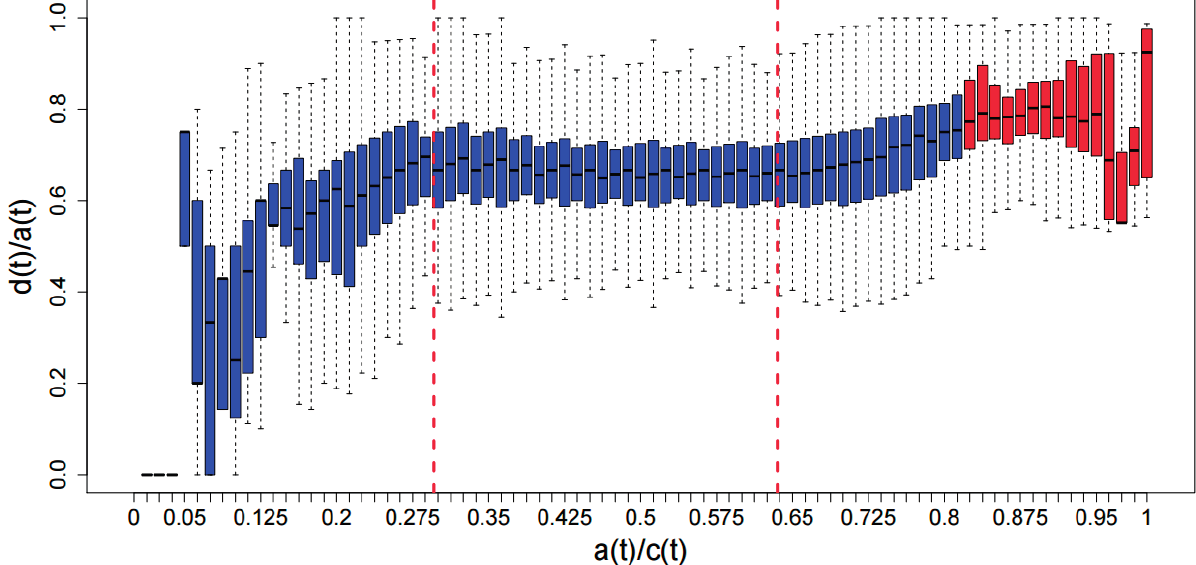
Figure 4. Graph of boxplots for concentration of A codons , a ( t )/ c ( t ), versus the relative concentration of D codons , d ( t )/ a ( t ). Blue boxes correspond to current windows, whereas the red ones correspond to the ADAT stretches . Multiple linear regression based on the mean values found two breakpoints at a ( t )/ c ( t ) 0.296 and 0.635 (dashed red lines) (See Figure S5 for more